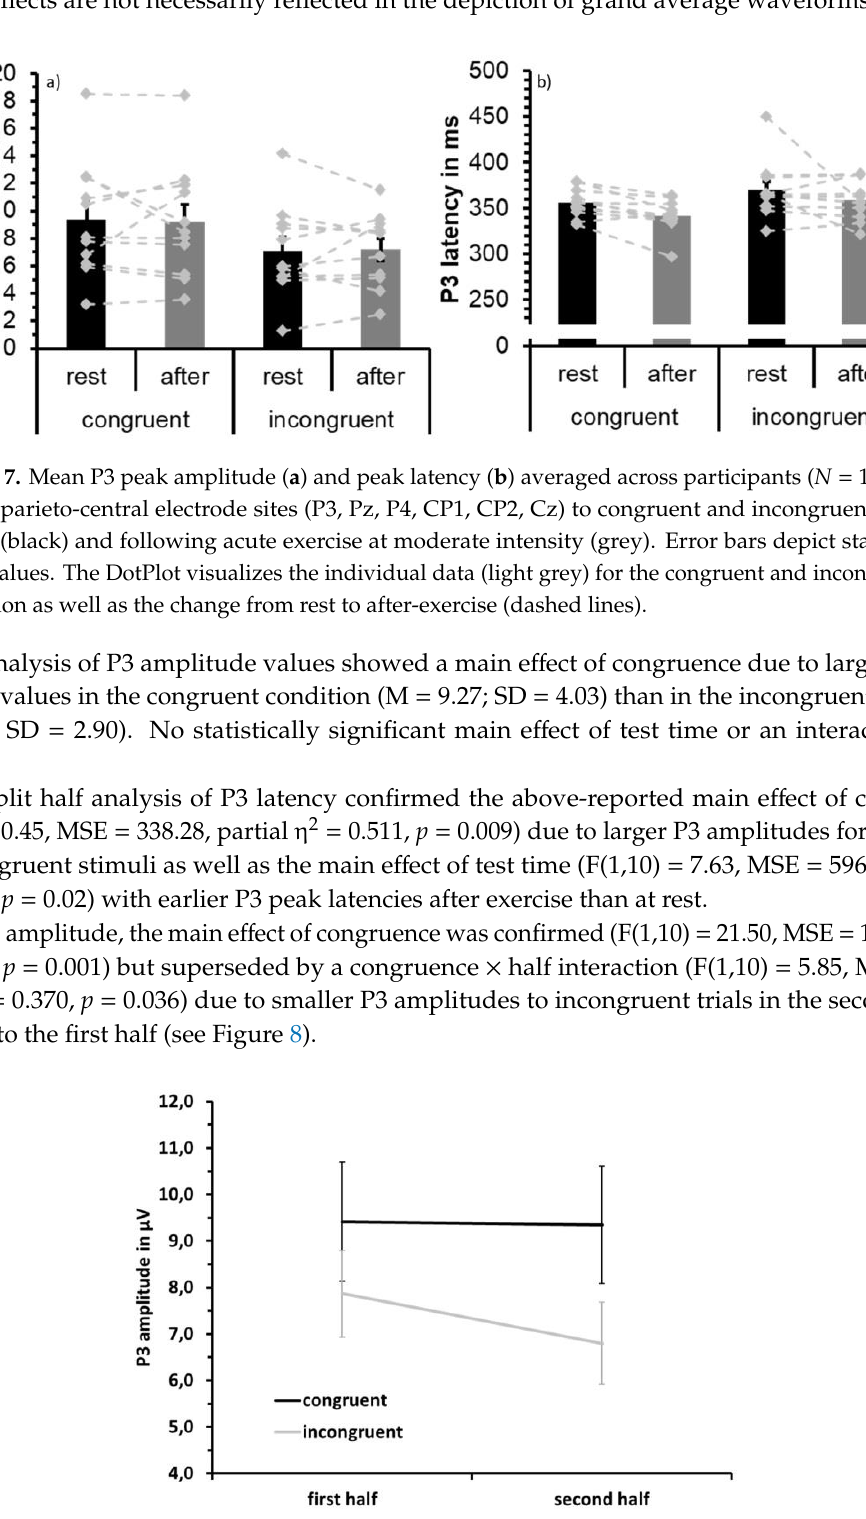
Figure 6. Grand average ERP waveform ( N = 11) averaged across parieto-central electrode sites (P3, Pz, P4, CP1, CP2, Cz) depicting the neural responses (in particular the P3) to congruent (solid) and incongruent (dashed) trials at rest (black) and immediately after an acute bout of moderate-intensity exercise (grey). Topographical distributions at the time of P3 peak are shown for the congruent condition at rest (solid, black frame) and after exercise (solid, grey frame).